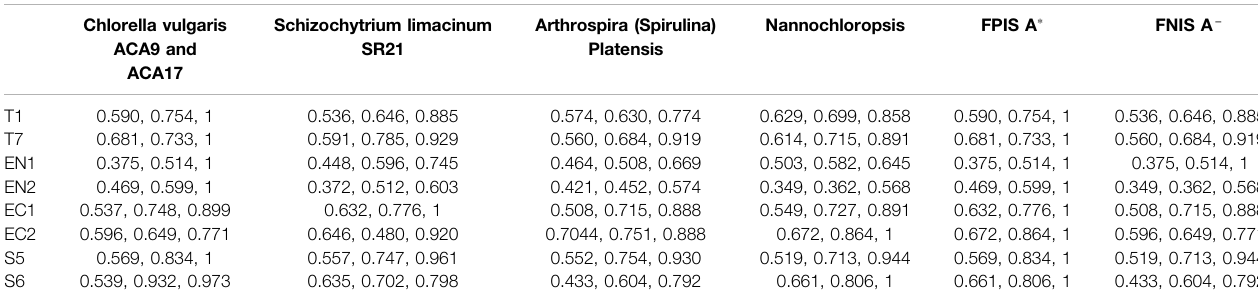
TABLE 9 | normalized fuzzy decision matrix, FPIS and FNIS. Chlorella vulgaris ACA9